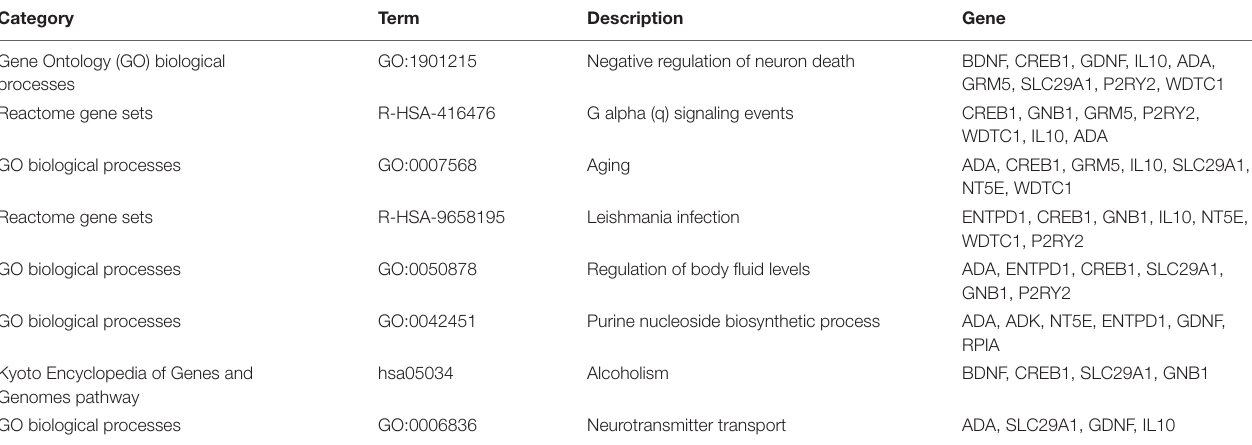
TABLE 5 | Pathway and process enrichment analysis of 14 ADORA2A target